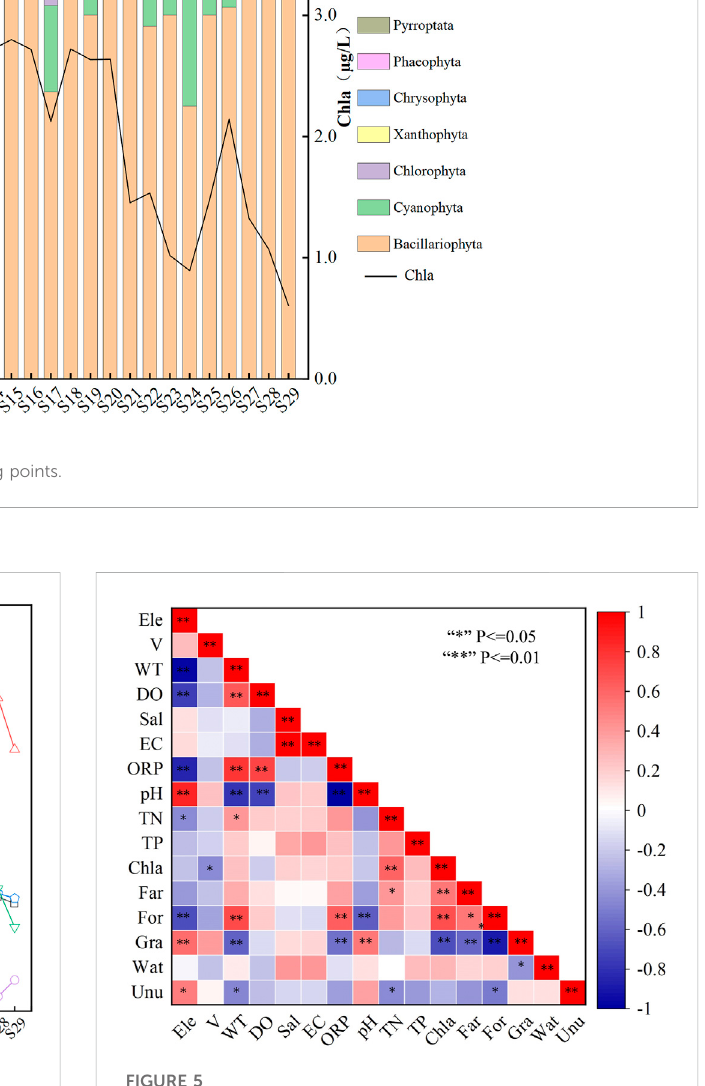
FIGURE 4 Variation of diversity index at different sampling points.